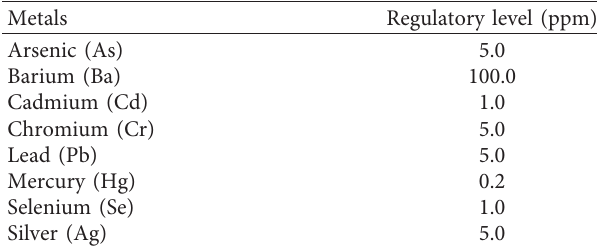
Table 4: Metals’ hazardous waste parameters by the US EPA